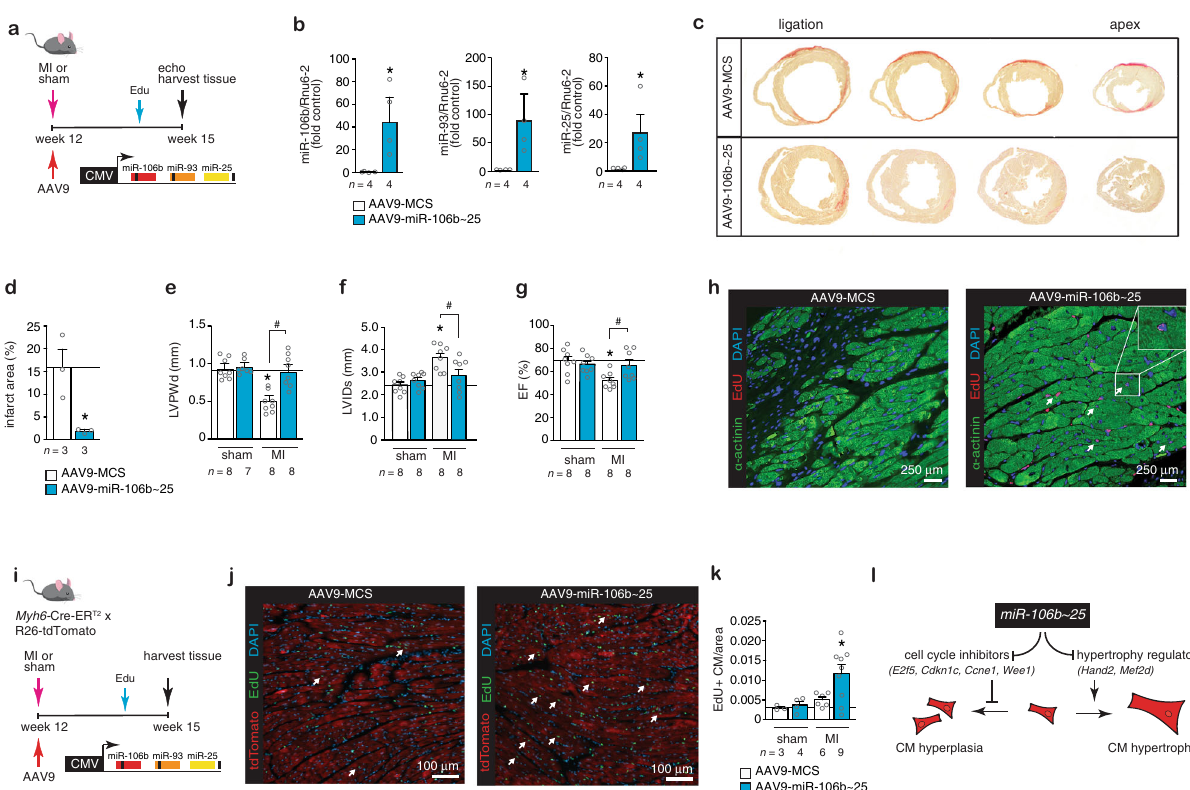
Fig. 6 The miR-106b~25 cluster evokes myocardial regeneration. a Design of the study. b Real-time PCR analysis of miR-106b , miR-93 and miR-25 abundance in infarcted hearts receiving AAV9-MCS or AAV9-miR-106b~25. c Representative images of Sirius Red-stained ventricular cross-sections from the point of ligation toward the apex of hearts post-MI, treated with AAV9-MCS or AAV9-miR-106b~25. d Quanti fi cation of the infarct area of the post- infarcted left ventricles from mice receiving AAV9-MCS or AAV9-miR-106b~25. Quanti fi cation of e LVPWd, f LVIDs, and g EF of mice that received AAV9-MCS or AAV9-miR-106b~25 after sham or MI surgery. i Representative images of the infarct border zone of mice treated with AAV9-MCS or AAV9-miR-106b~25 after MI surgery, and stained for α -actinin and EdU; n refers to the number of animals. i Design of the lineage tracing study. j TdTomato expression overlaps with 5-ethynyl-2 ’ -deoxyuridine (EdU). k Quanti fi cation of TdTomato + , EdU + CMs. l Schematic representation of the model. * P < 0.05 vs corresponding control group; # P < 0.05 vs corresponding treatment group (error bars are s.e.m.). Statistical analysis consisted of a two- tailed Student ’ s t -test ( b , d ) or a One-way ANOVA followed by Dunnett multiple comparison test ( e – g , k ). Source data are provided as a Source data fi le.